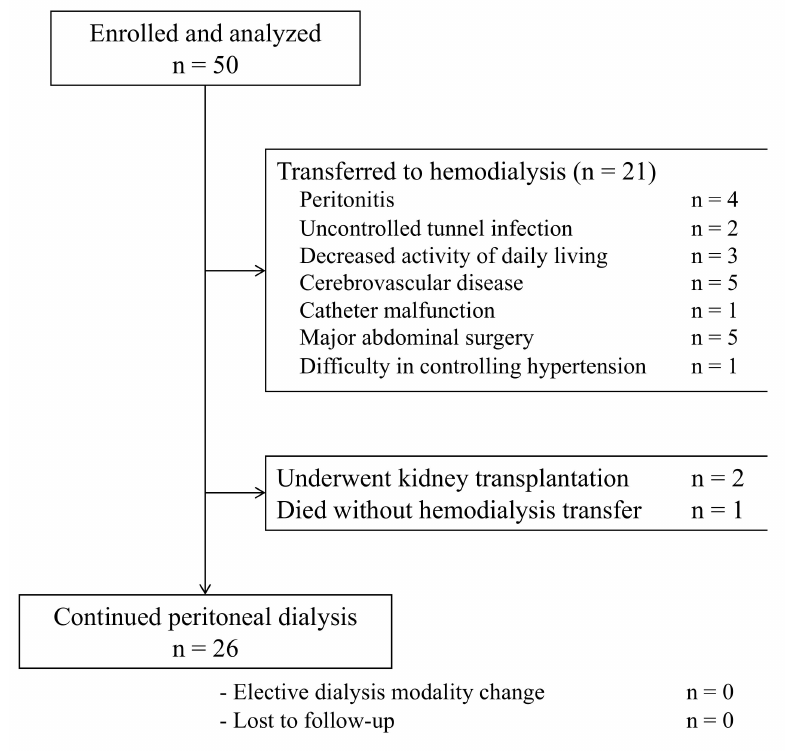
Figure 1. Flow chart of the study participants. Table 1. Baseline clinical characteristics of the study